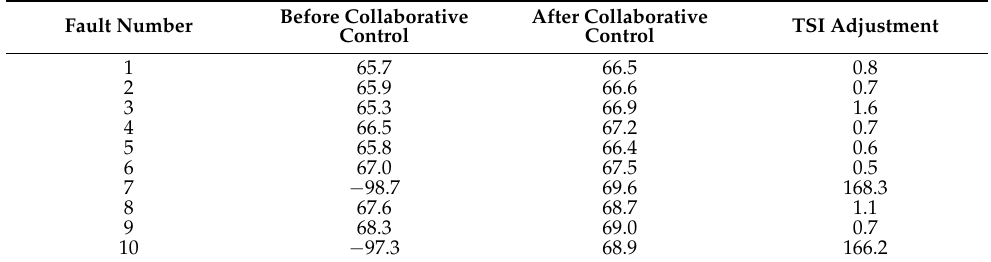
Table 6. Comparison of TSI before and after collaborative transient stability control of IEEE 30 bus system. Fault